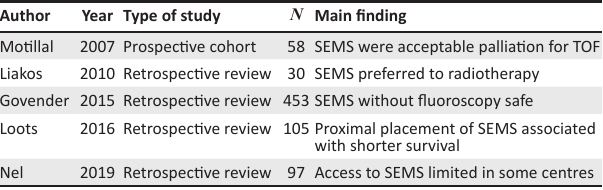
TABLE 4: Studies of palliation of oesophageal cancer by placement of self- expanding metal stents in South Africa.